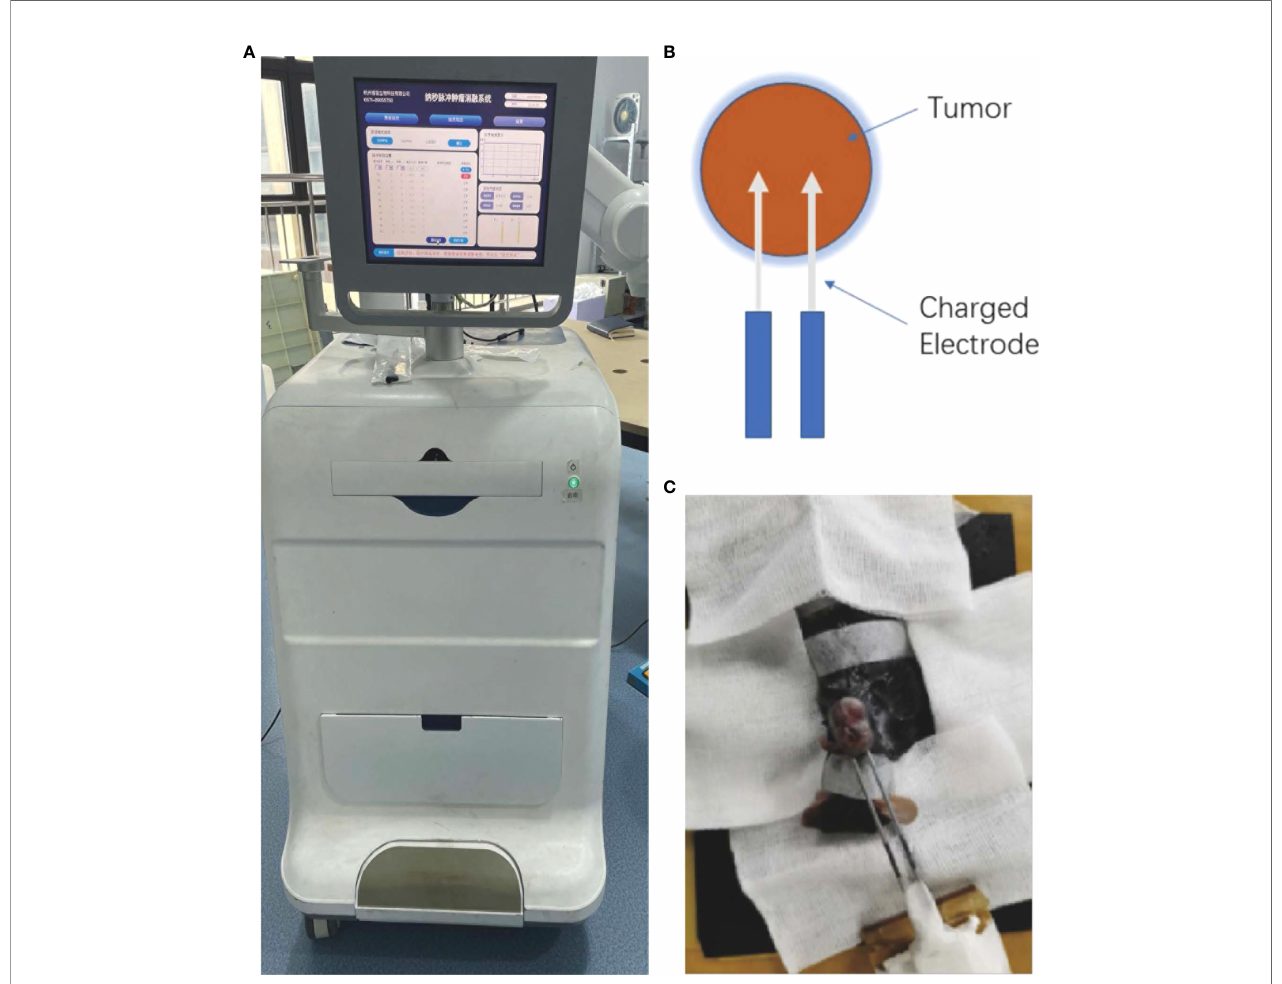
FIGURE 1 | (A) Image of the nanosecond-pulsed tumor ablation system. (B) Schematic illustration of the treatment strategy. (C) Representative photograph showing nsPEFs electrode placement within the targeted